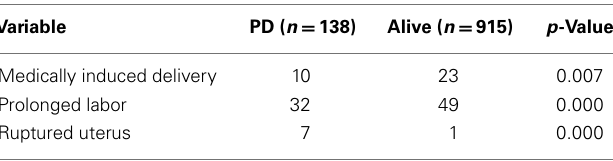
Table 4 | Maternal delivery characteristics association with perinatal deaths .